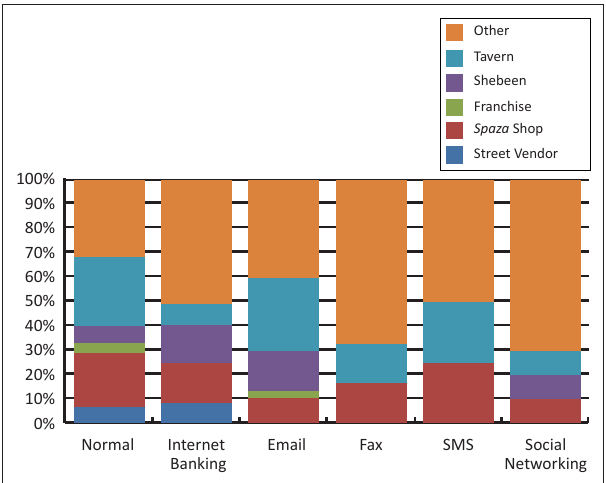
FIGURE 12: Correlation between laptop usage and type of